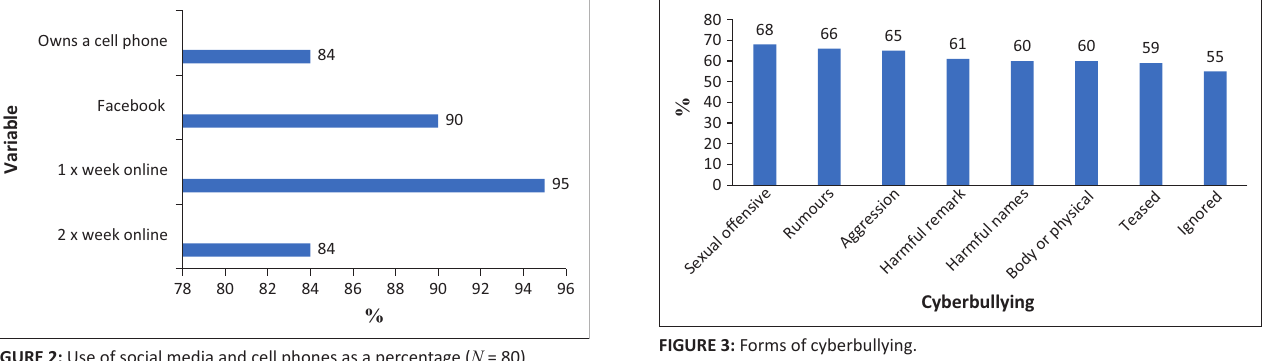
FIGURE 2: Use of social media and cell phones as a percentage ( N = 80).